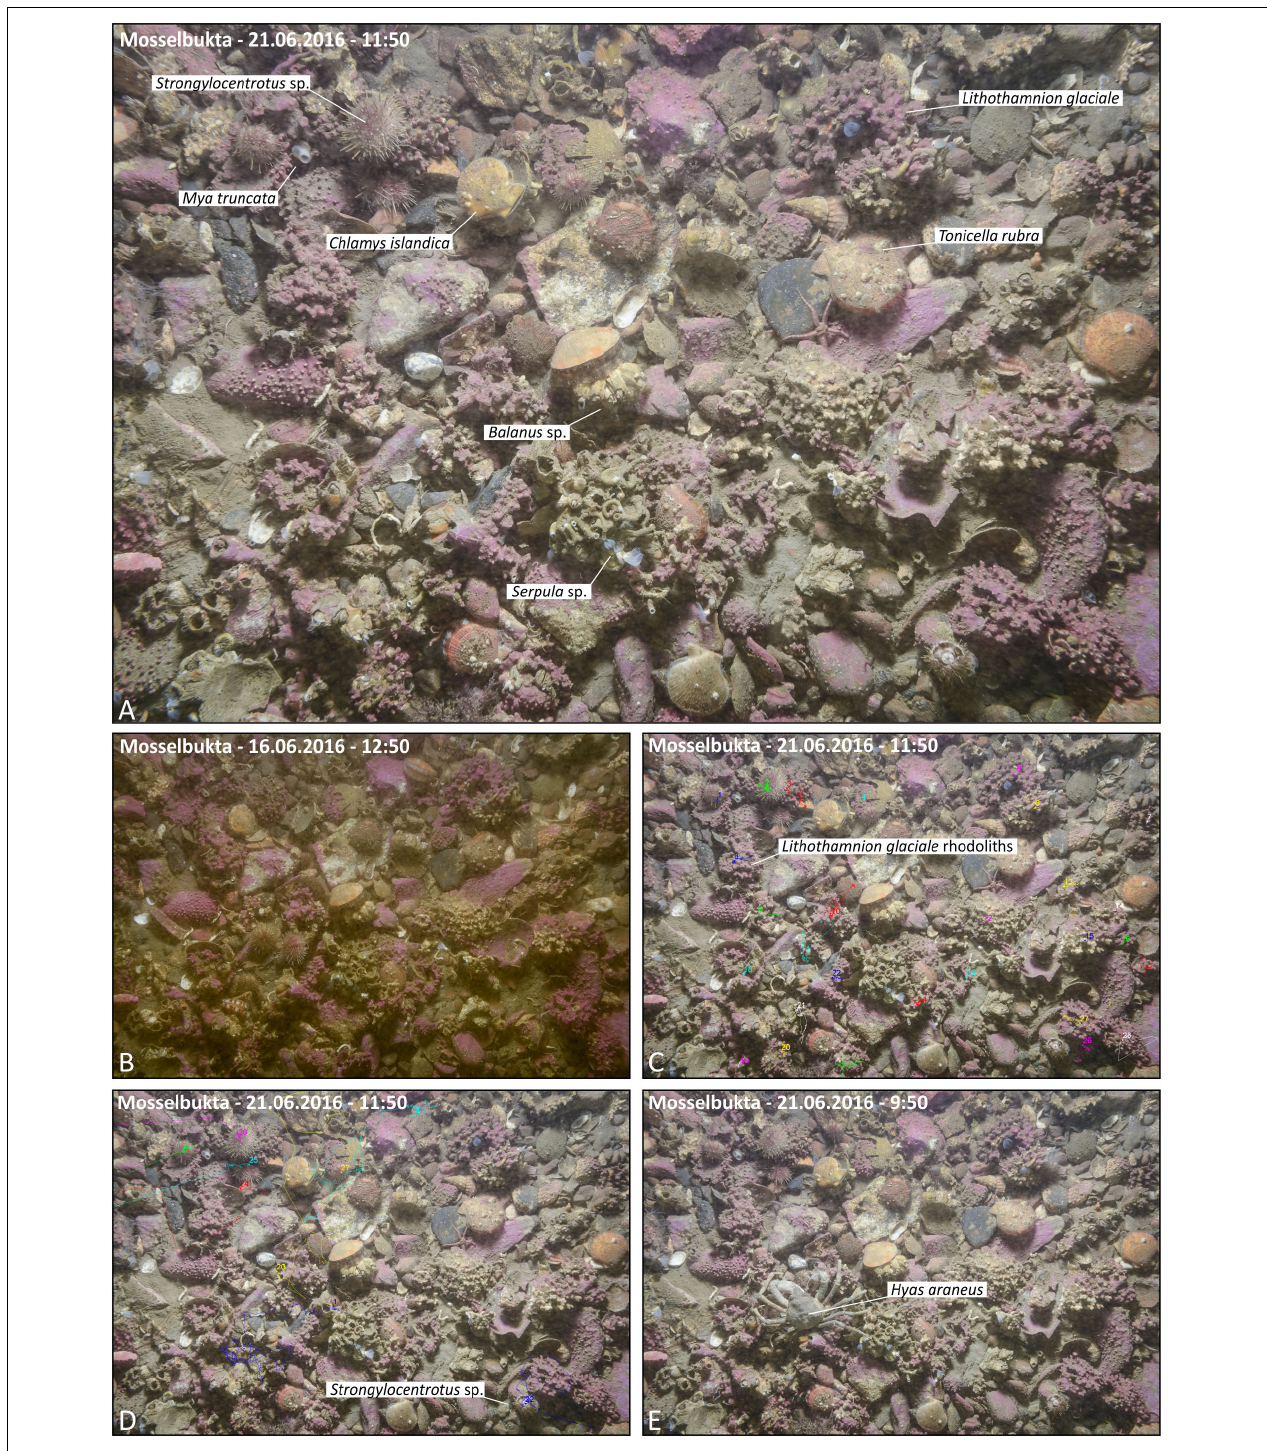
FIGURE 11 | Selected seafloor images (field of view = 86 × 57 cm) taken by the lander’s camera system during the 6 days of deployment at 46 m water depth in the rhodolith belt in Mosselbukta: (A) Last image in the series, with labels for those species that have either been tracked and/or analysed for feeding activity. (B) First image in the series; note the marked difference in turbidity and thus image contrast. (C) Last image in the series with the labelled tracks of the Lithothamnion glaciale rhodoliths. (D) Last image in the series with the labelled tracks of the echinoid Strongylocentrotus sp., the main agent of moving around rhodoliths. (E) Another trigger for movement of rhodoliths and other organisms is the great spider crab Hyas araneus